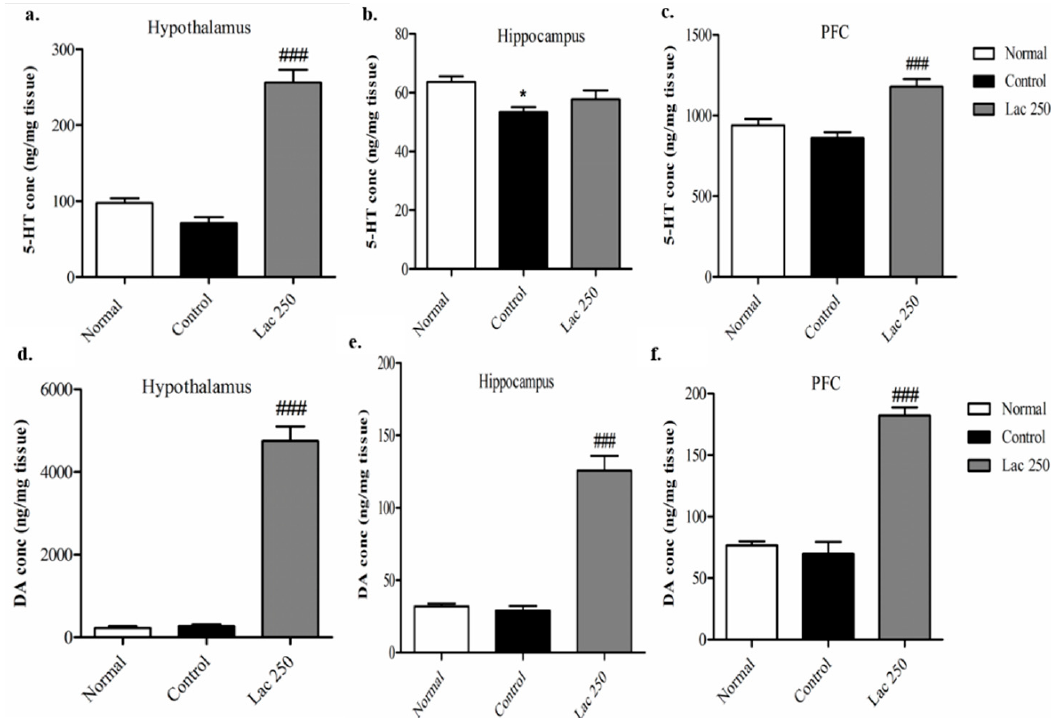
Figure 5. Effect of oral lactate administration on serotonin (5-HT) and dopamine (DA) concentrations in different brain areas in ovariectomized rats with stress. The levels of 5-HT concentration (nanogram per milligram) in the hypothalamus ( a ), hippocampus ( b ), and prefrontal cortex ( c ) changed after repeated lactate administration. The levels of DA concentration (nanogram per milligram) in the lactate 250 group in the hypothalamus ( d ), hippocampus ( e ), and prefrontal cortex ( f ) ( n = 6). Values are presented as mean ± SEM. * show differences between the normal and control groups, while ### show significant differences between the control and treatment groups. ### p < 0.001. The p -value of the test was